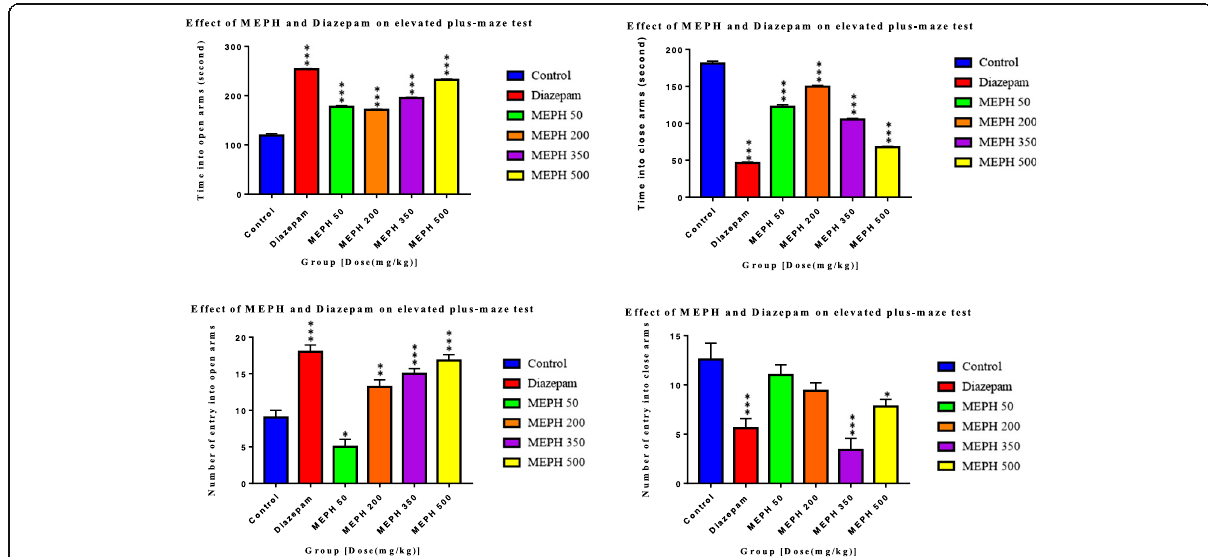
Fig. 5 The effect of MEPH on elevated plus-maze test (Time spent in open arms; Number of entries in open arms; Time spent in close arms; Number of entries in close arms) in mice